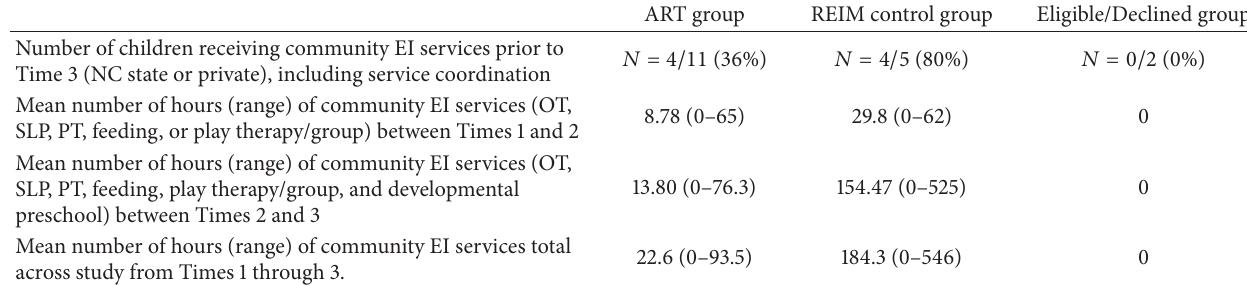
Table 2: Dosage of community EI services utilized by groups across study